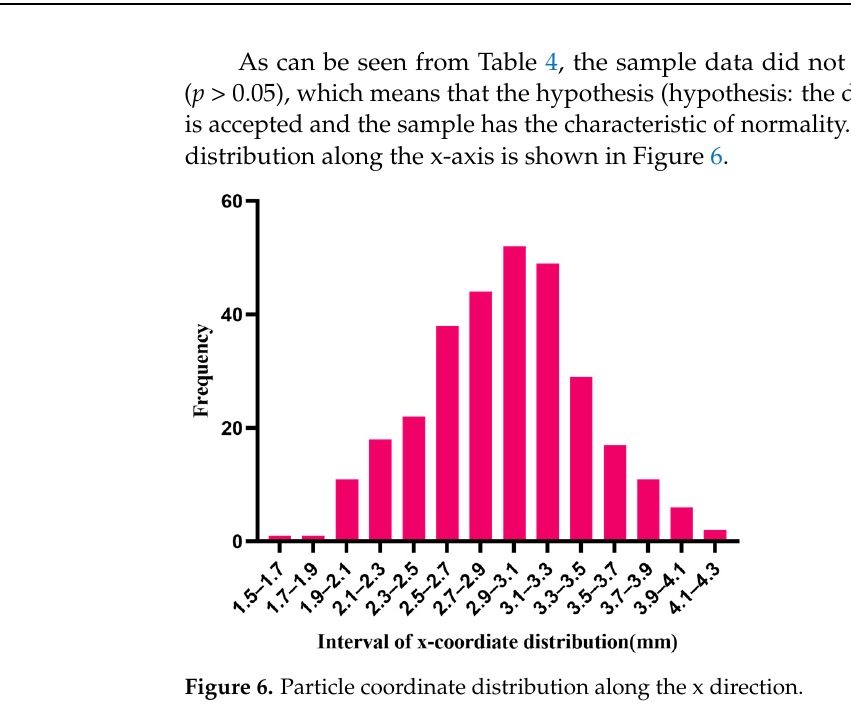
Figure 6. Particle coordinate distribution along the x